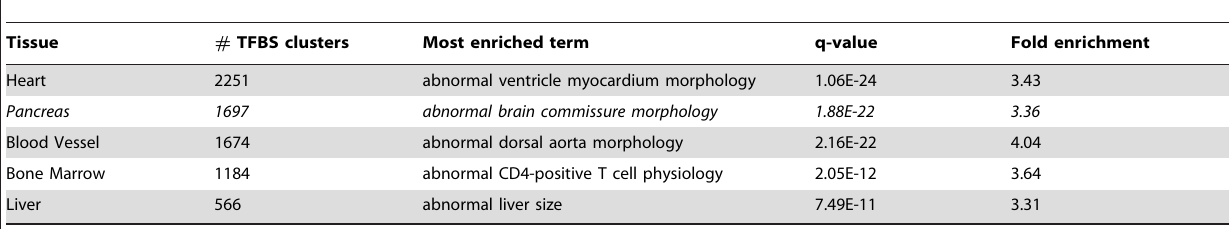
Table 3. TFBS clusters for other tissues.